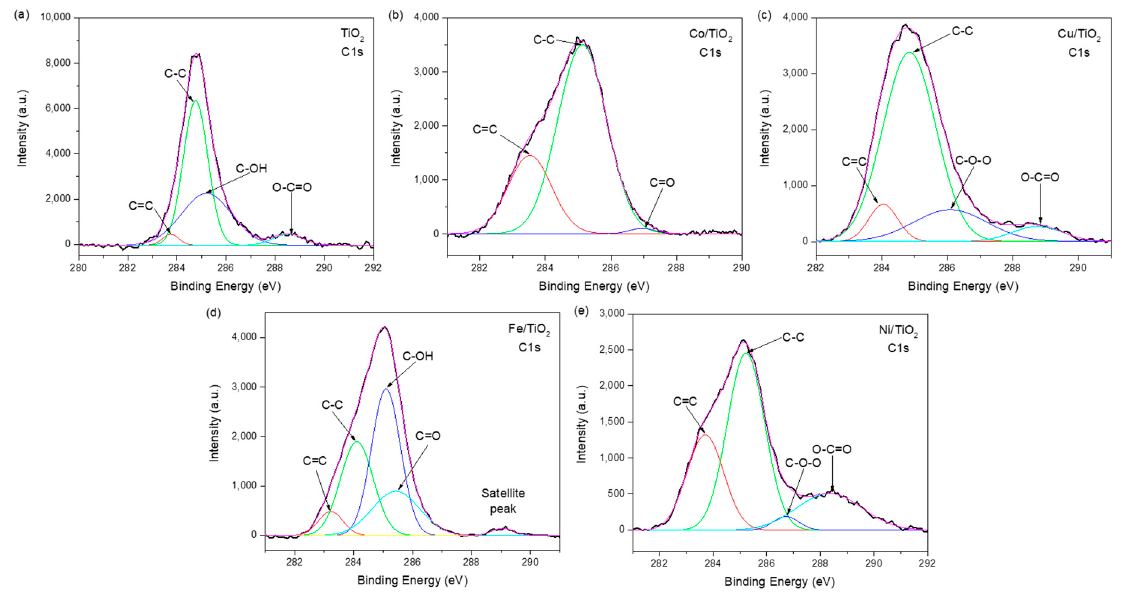
Figure 11. C1s XPS spectrum of: ( a ) TiO 2 , ( b ) Co/TiO 2 , ( c ) Cu/TiO 2 , ( d ) Fe/TiO 2 and ( e ) Ni/TiO 2 .